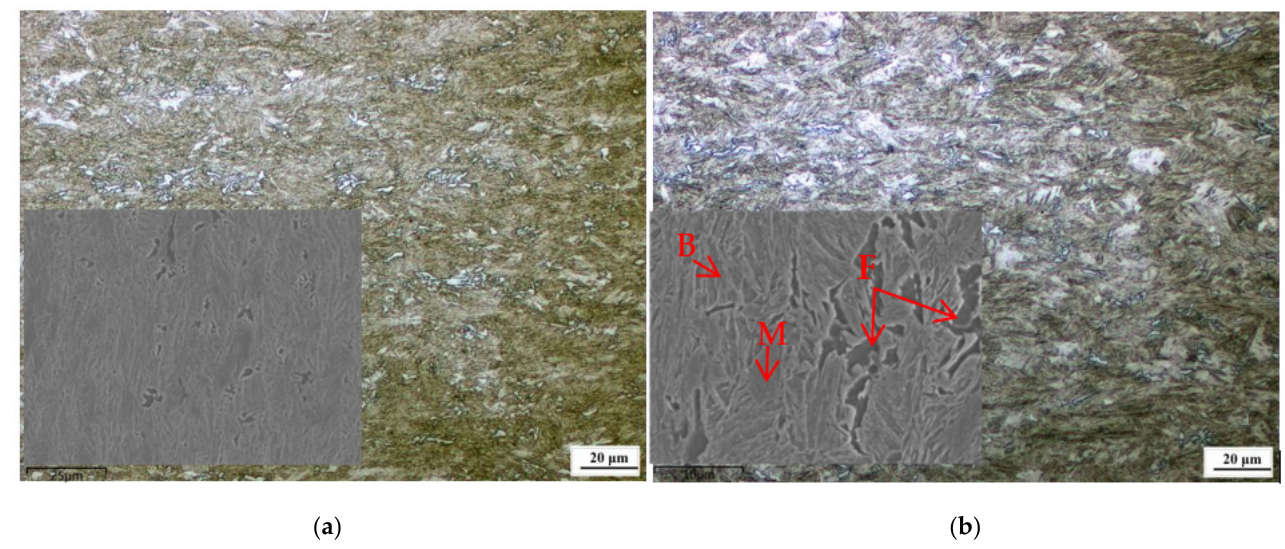
8 of 15 Figure 11. Microstructure of 2# as-cast tested steel (( a , b , c ) represent 50×, 100× and 200×, respec- tively). Figures 12 and 13, respectively, represent the microstructure of the wear-resistant steel plates at different positions along the thickness direction of the 1# and 2# tested steels. The microstructure of the 1# tested steel is mainly bainite ferrite(B), supplemented by fer- rite(F) and martensite(M), while the microstructure of 2# tested steel is mainly bainite fer- rite(B), supplemented by martensite(M) at room temperature, the ferrite basically disap- pears, the proportion of bainite ferrite increases and the proportion of martensite de-